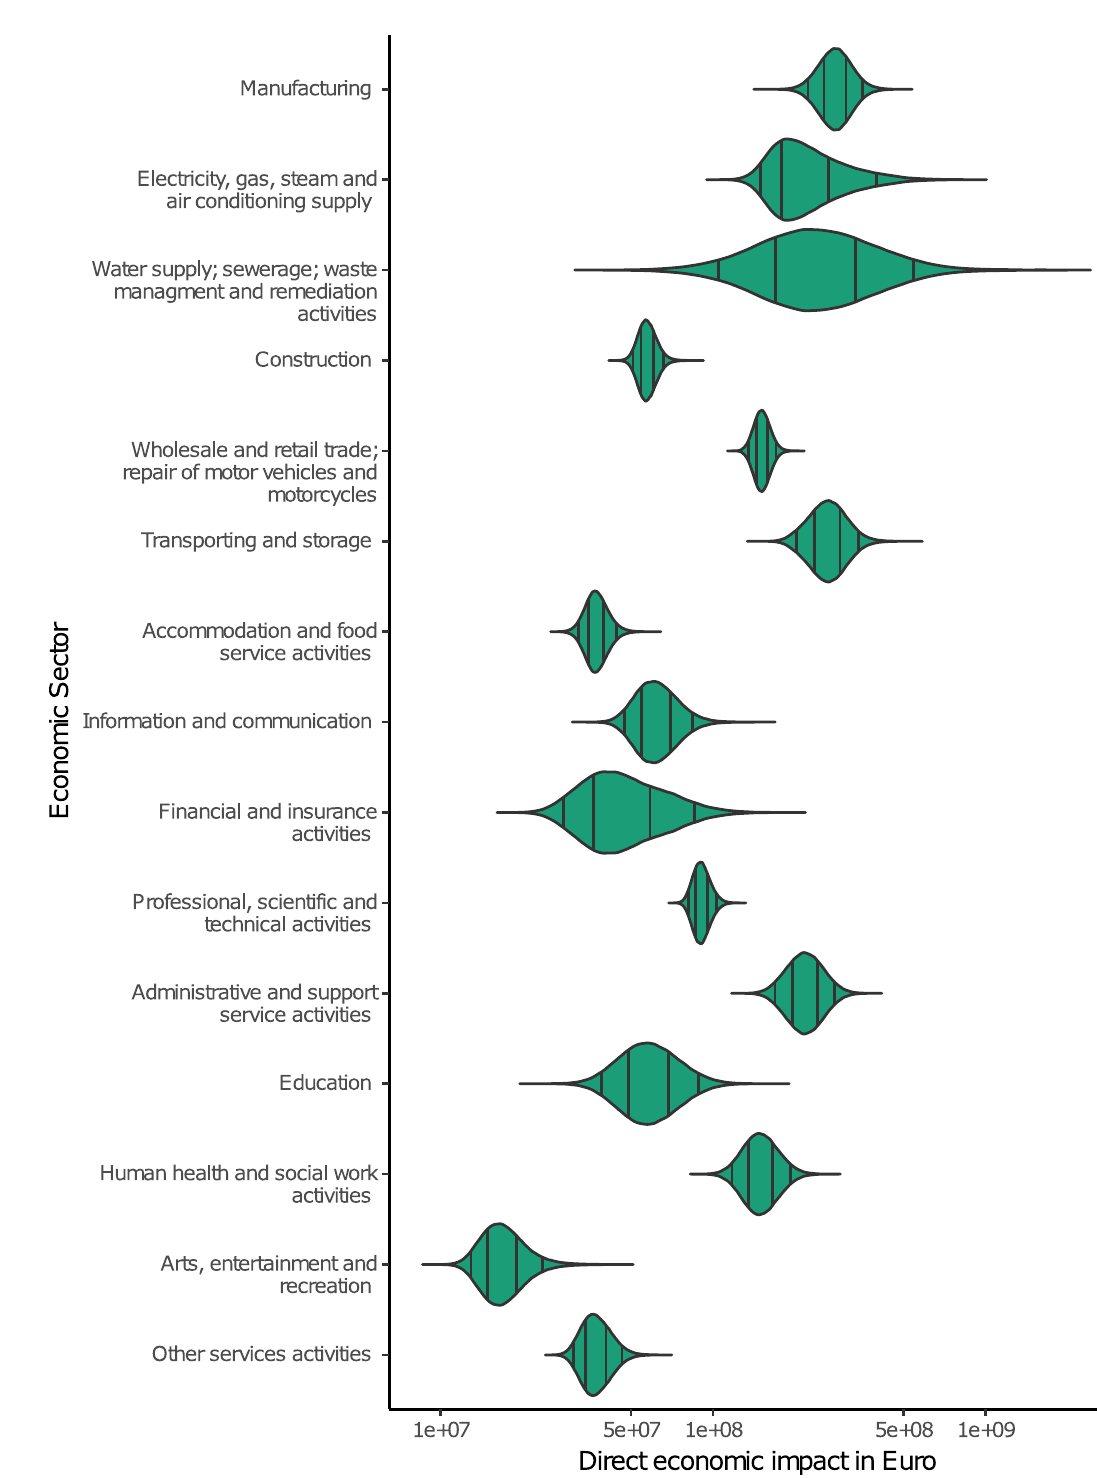
Fig 3. Distributions of estimated direct economic impacts per economic sector. The black lines indicate the 50% and 90% intervals.